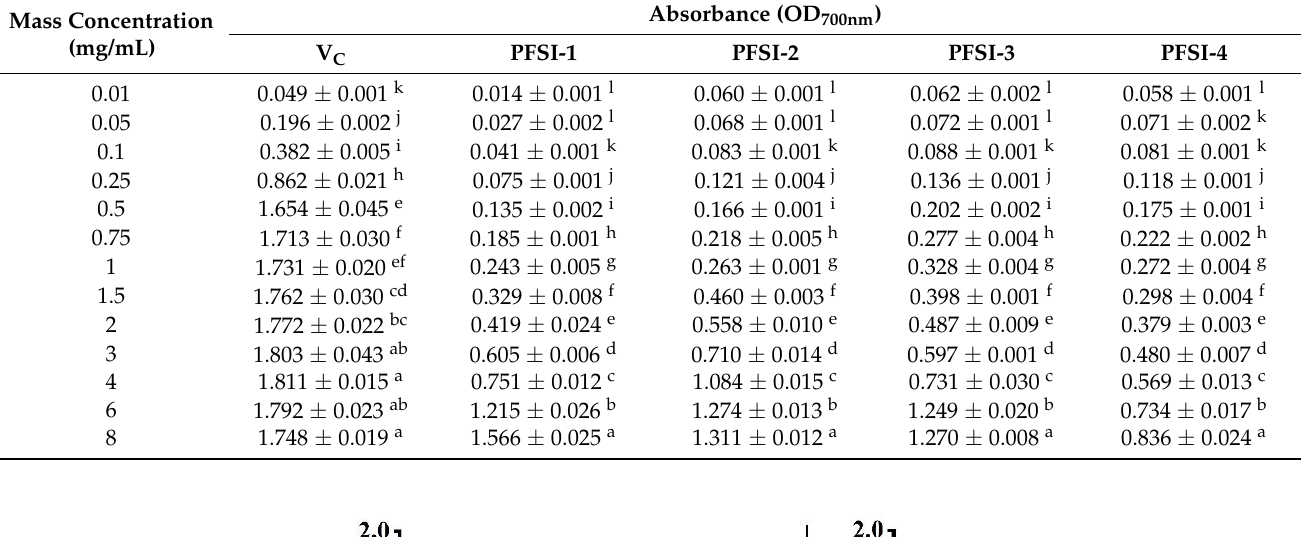
Table 7. Total reduction capacity of PFSI-1, PFSI-2, PFSI-3, and PFSI-4. (Note: same lowercase letters indicate no significant difference between groups, different lowercase letters indicate a significant difference between groups, p < 0.05).